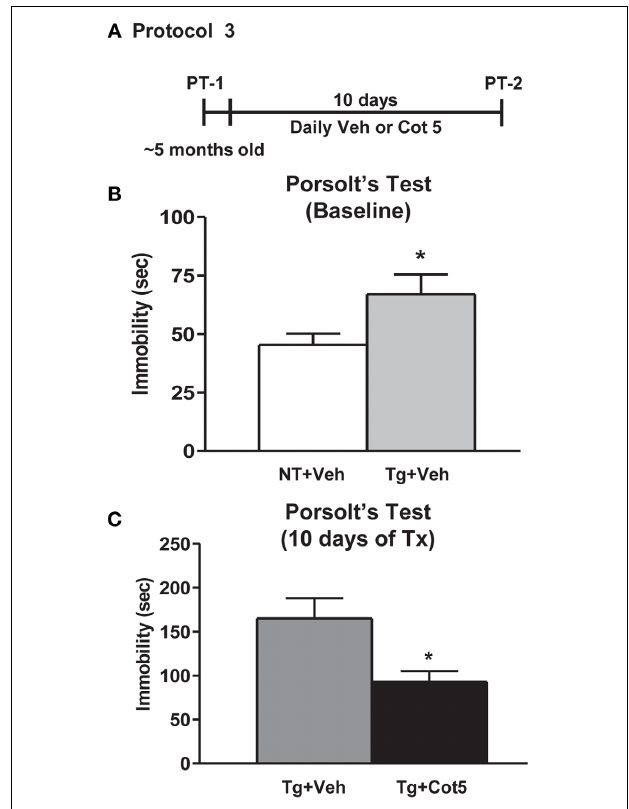
FIGURE 3 | Cotinine diminished depressive-like behavior in Tg6799 mice. At 4.5–5 months of age, naïve transgenic (Tg) mice and non-transgenic (NT) littermates ( n = 16 per group) were tested for basal levels of depressive-like behavior in the Porsolt’s forced swim test (PT-1; A ). Tg mice displayed significantly greater immobility times than NT counterparts ( t = 2 . 158, df = 30, ∗ p = 0 . 0391; B,C ). Following 10 days of treatment with cotinine (5mg/kg) or vehicle, Tg6799 mice were retested in the PT (PT-2). Cotinine-treated Tg mice (Tg + Cot 5) showed significantly less immobility than vehicle-treated Tg (Tg + Veh) cohorts ( t = 2 . 775, df = 14, ∗ p = 0 . 0149). sec, seconds; Tx,